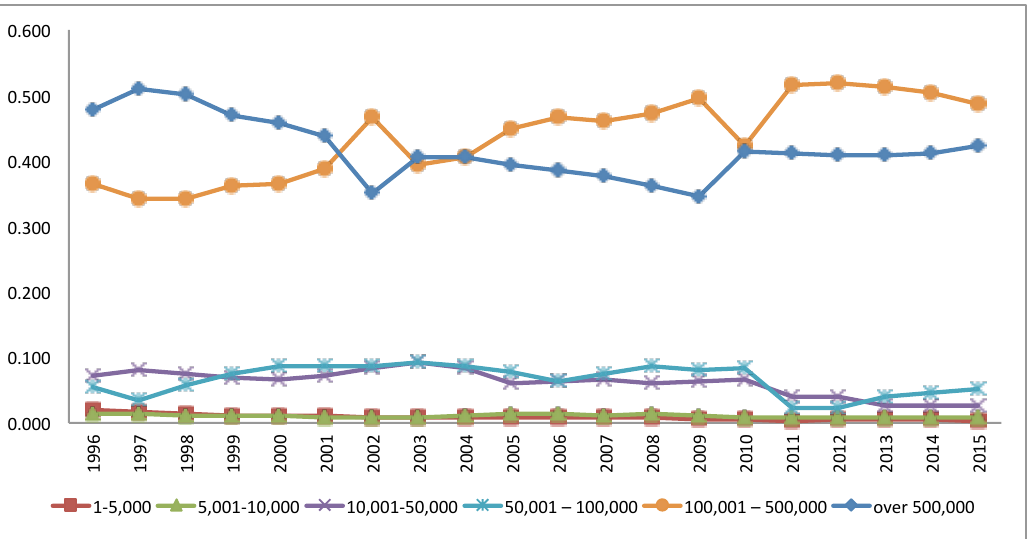
Figure 1. Development of the market share by insurer size.